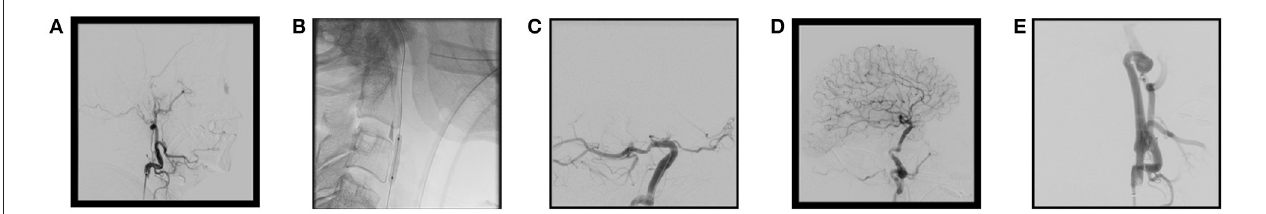
FIGURE 1 | (A) Extracranial occlusion of the Internal Carotid Artery. (B) Ballon-PTA (5mm) before passing with the 8F-Guiding Catheter. (C) Carotid-T-occlusion with already placed Stent retriever. (D) TICI III recanalization after thrombectomy. (E) Stent-placement in extracranial internal carotid artery after thrombectomy.